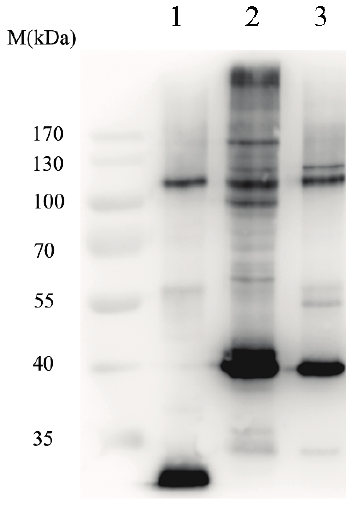
Figure 2. Isolation of SUMO conjugates by immunoprecipitation. Enhanced green fluorescent protein (eGFP), eGFP-SUMO and ubiquitin carrier protein 9 of Bombyx mori (BmUBC9), and eGFP-SUMO were expressed in baculovirus vectors and subjected to GFP immunoprecipitation. The immunoprecipitated proteins were then separated by SDS-PAGE and subjected to western blot analysis with an anti-eGFP antibody. Lane 1 , eGFP; Lane 2 , eGFP-SUMO and BmUBC9; Lane 3 , eGFP-SUMO